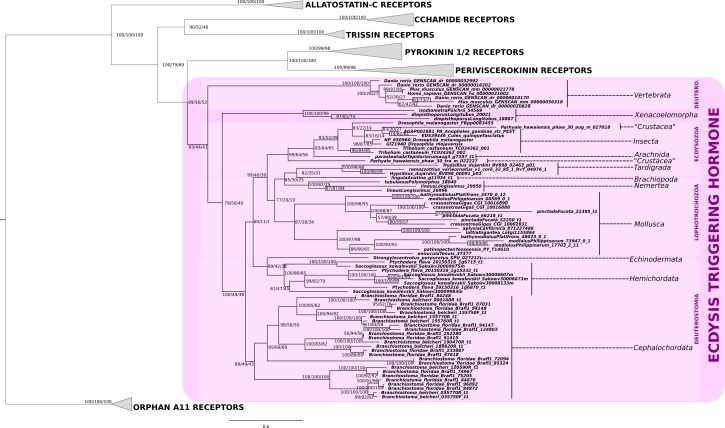
Phylogenetic analysis of the ecdysis-triggering hormone receptor showing the presence of ETH-receptor in bilaterians.Note a substantial expansion of the eth-receptor homologs in the genomes of the Branchiostoma floridae and B. belcheri. Support values for the tree nodes obtained from mrbayes, RAxML and PhyML are shown as percentage. Tree topology obtained from RaXML was used as a backbone, and conflicting topology branches from RAxML and PhyML inferred trees are marked by brackets ([]) around the support values.